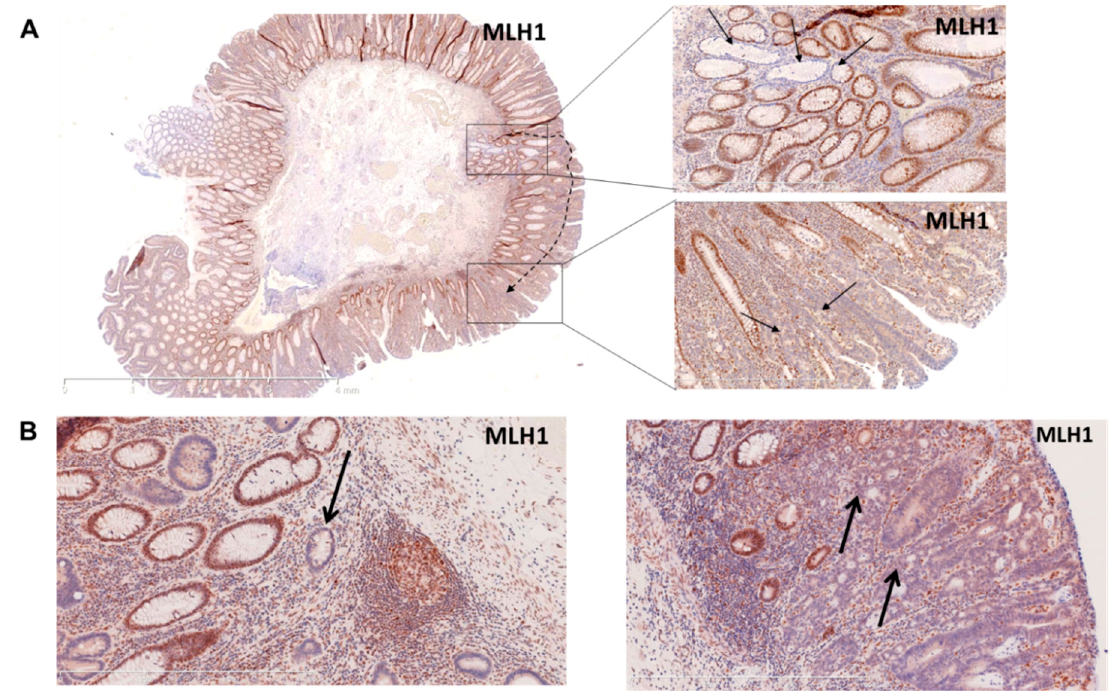
Figure 2. Histology images of tumor specimens with MMR ‐ deficient crypt foci. ( A ) Resection sample with carcinoma in situ arising presumably from an MMR ‐ deficient crypt. On the left panel, the overview of the resected sample (MLH1 staining); on the right upper panel, higher magnification of the MMR ‐ deficient crypt (MLH1 staining); on the right lower panel, higher magnification of carcinoma in situ (MLH1 staining). ( B ) MLH1 staining revealing an MMR ‐ deficient crypt (indicated by an arrow), on the left and another region of the same sample showing a non ‐ invasive carcinoma in situ (indicated by arrows) on the right panel.